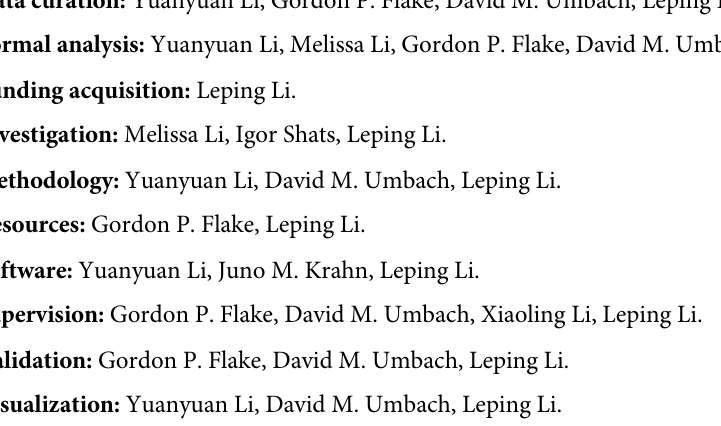
S1 Fig. Boxplots of the expression of the ten most frequently selected genes. Both RNA-seq and clinical classification data were obtained from TCGA. S2 Fig. Boxplots of the expression of miR-205 in melanoma samples. Both RNA-seq and clinical classification data were obtained from TCGA. S1 Table. TCGA tumor samples analyzed by RNA-seq (May 2015). S2 Table. Top 200 most correlated genes with GPC6. Each cell lists the Pearson correlation coefficient between the expression level of GPC6 and that of the gene (row) in a TCGA tumor type (column). S3 Table. The 50 cell adhesion genes among the top 200 most highly correlated with GPC6 across the 32 TCGA tumors. S4 Table. Top 10 significant GO terms (GOTERM_BP_ALL) that are associated with the top 200 genes mostly correlated with GPC6 in 1,156 CCLE